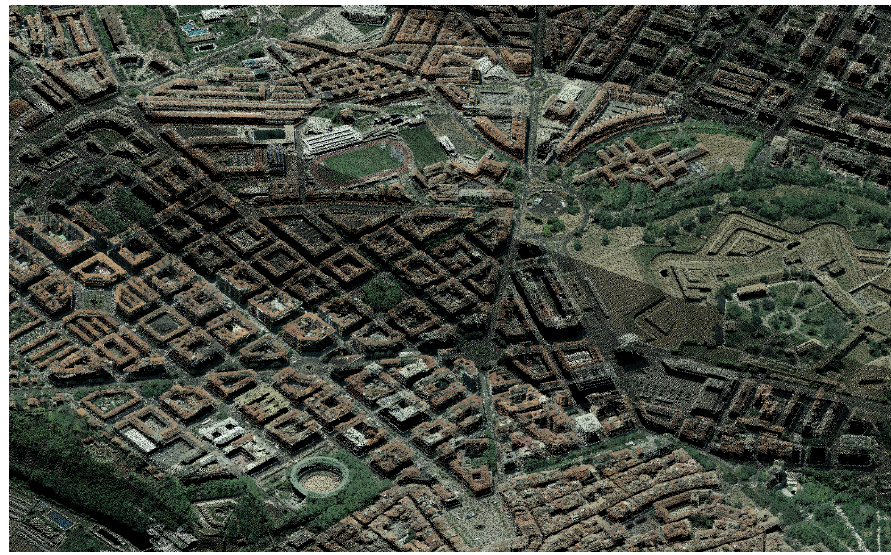
Figure 1. Partial view of Dataset 1 (Pamplona